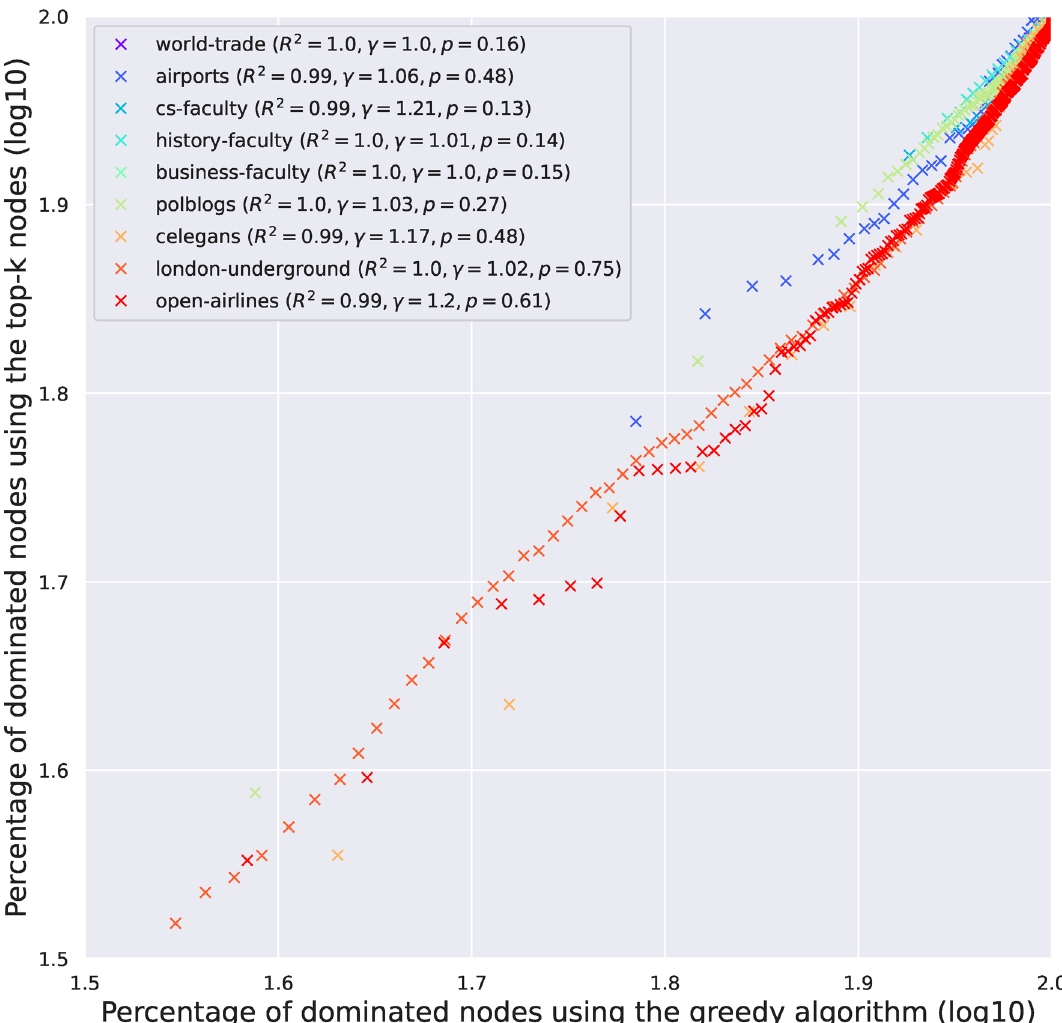
Figure 2. Log-log plot between the percentages of dominated nodes when running the greedy ( 1 − 1 / e ) -maximum coverage algorithm of Ref. 18 ( x -axis) and selecting nodes according to their hierarchy, i.e. in order of descending initial degree ( y -axis). The slope γ and R 2 of linear fits are reported. The rule that selects nodes based on their prestige h yields very close results to the greedy maximum coverage algorithm. In general instances, these two algorithms are expected to have different results, since the former algorithm may select prestigious nodes whose neighborhoods have large overlaps which may not yield good coverage in general. However, specifically in core–periphery networks, high prestige nodes seem to have small overlaps, which justifies the good performance of the prestige-based algorithm. Source code to reproduce the Figure can be found in Ref. 33